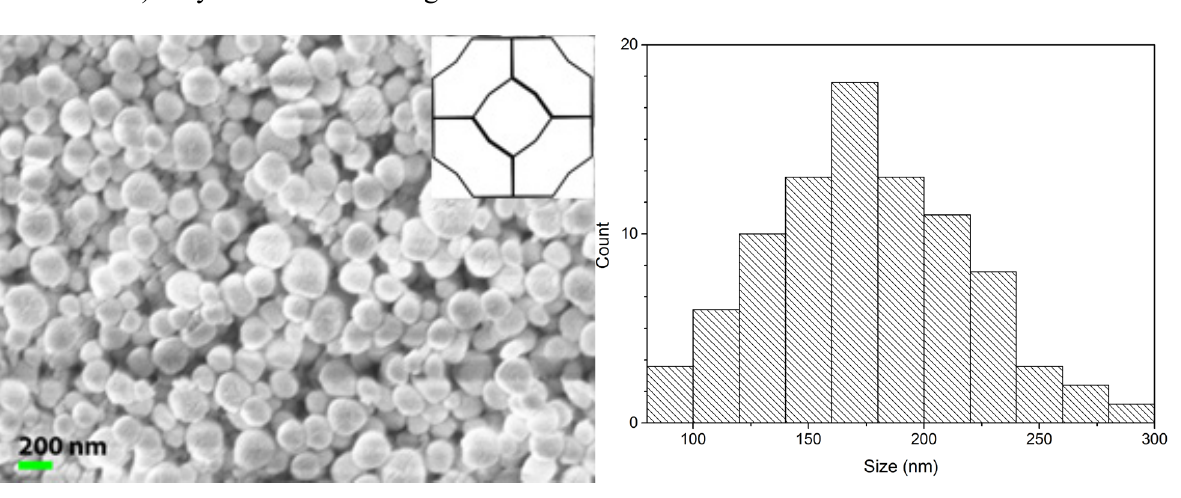
Figure 1. SEM image of Linde Type A (LTA) crystals as synthesized (inset: LTA structure). Crystals had an average size of 175 ± 43